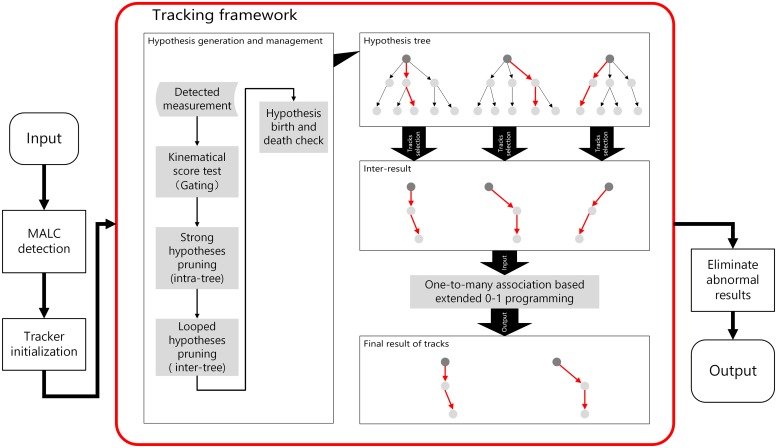
The proposed tracking framework.